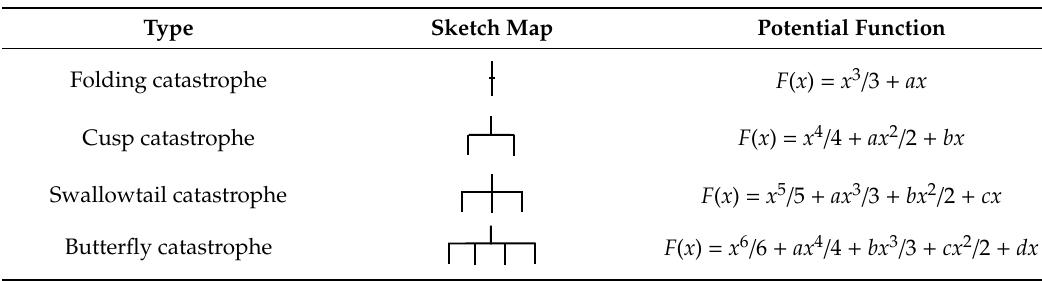
Table 1. Commonly used catastrophe models.